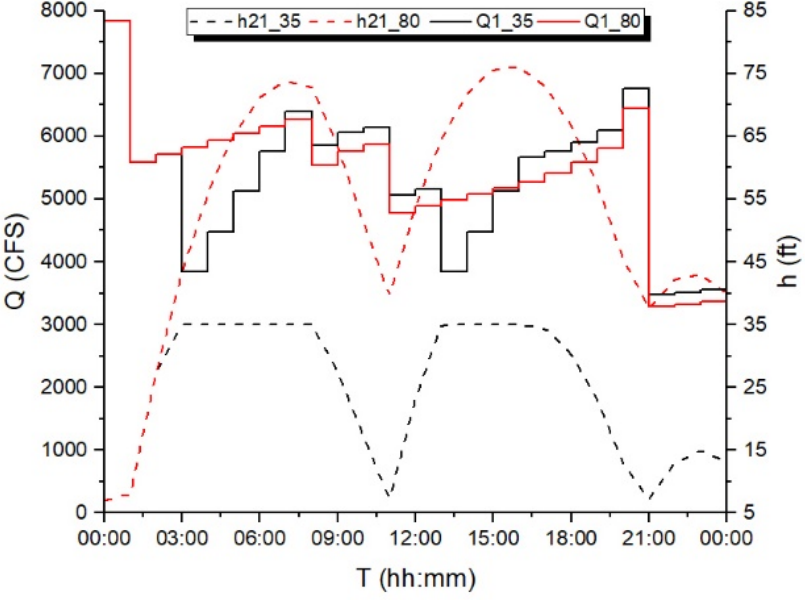
Figure 2. Results of the pump scheduling model by [39] for Anytown